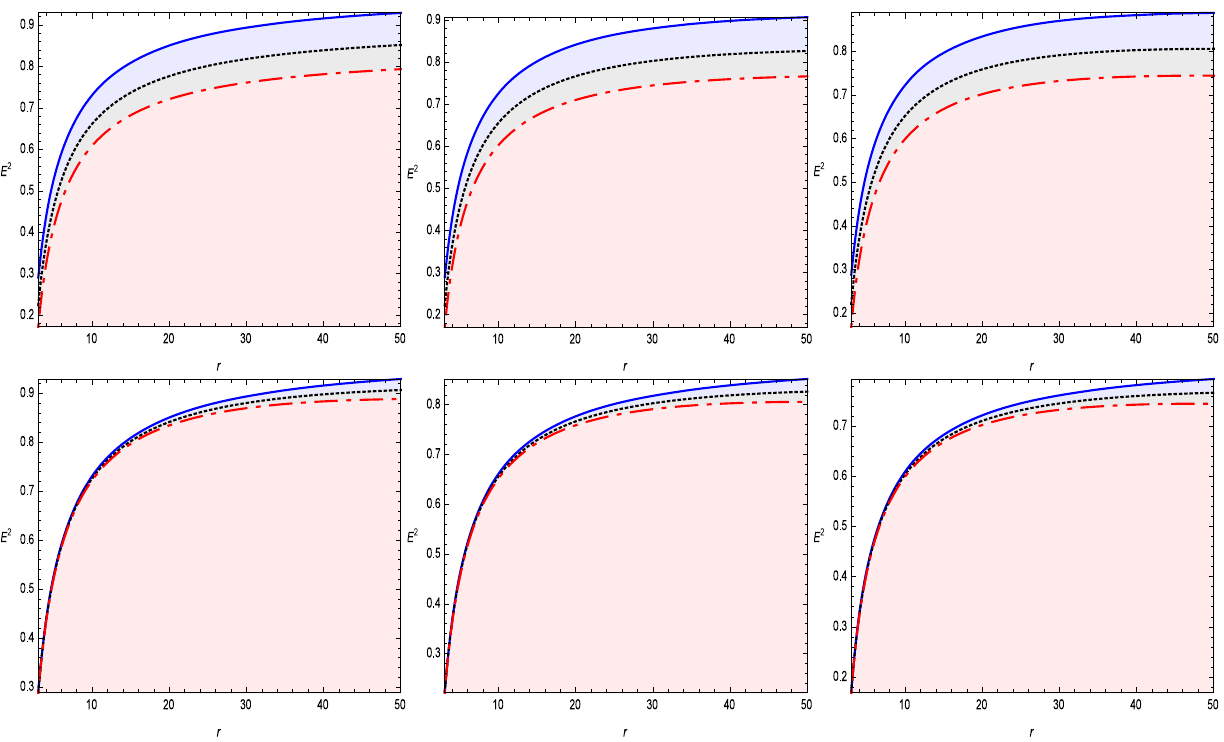
Fig. 8 Shows the behavior of E 2 for the different possible values of a and q . The left panel of the first row represents q = 0 . 05 (blue), q = 0 . 06 (black), and q = 0 . 07 (red) with a = 0 . 7. The middle panel of the first row represents q = 0 . 05 (blue), q = 0 . 06 (black), and q = 0 . 07 (red) with a = 0 . 8. The right panel of the first row represents q = 0 . 05 (blue), q = 0 . 06 (black), and q = 0 . 07 (red) with a = 0 . 9.